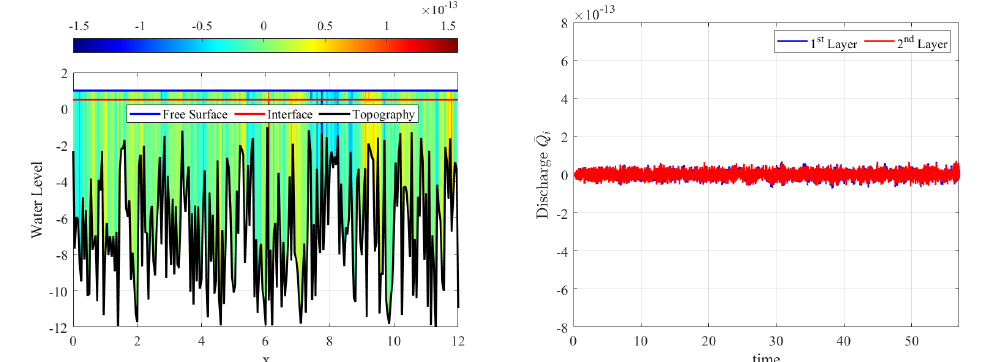
Figure 4. Snapshot of simulation results which show ( left ) flat surface and interface, with zero velocities (indicated by the color scale) and ( right ) nearly zero